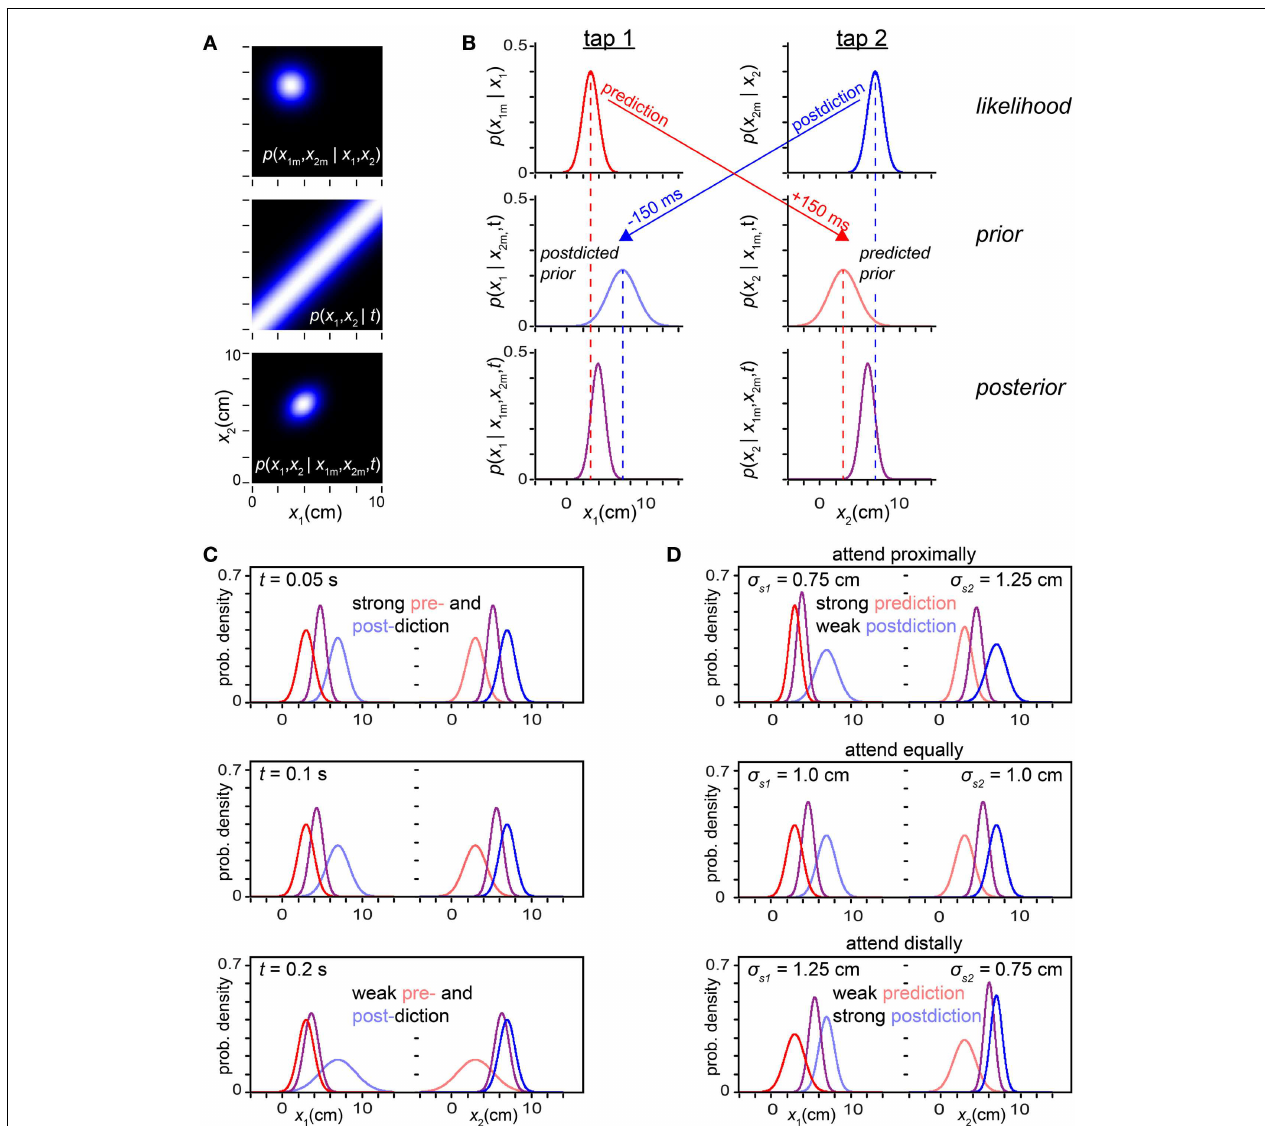
tap 1 posterior (purple). Right column : similarly, the observer multiplies the tap 2 likelihood function (blue) by the tap 2 predicted prior (light red) to obtain the tap 2 posterior (purple). (C) Individual tap likelihoods, priors, and posteriors graphed with the same color scheme as in (B) , for three trajectories of progressively increasing ISI. At t = 0.05s, pre- and postdiction both result in relatively sharp priors that exert a strong influence over the percept (mode of the posterior). As t is increased, the pre- and postdicted priors become lower and broader: pre- and postdiction become increasingly uncertain with the passage of time.The priors thus exert diminishing influence, and the percept approaches the measurement (compare to Figure 3A ). For all panels in (C) , σ s = 1cm, σ v = 10cm/s. (D) Effect of directed spatial attention, as in Figure 8 . Top : a reduction in σ s 1 sharpens the tap 1 likelihood function, increasing the strength of prediction (note sharp predicted prior over tap 2), while an increase in σ s 2 broadens the tap 2 likelihood function, decreasing the strength of postdiction (note broad postdicted prior over tap 1). Middle : when σ s 1 = σ s 2 , pre- and postdiction have equal strength. Bottom : reduction in σ s 2 relative to σ s 1 results in effects opposite those seen in the top panel. For all panels in (D) , t = 0.06s, σ v =